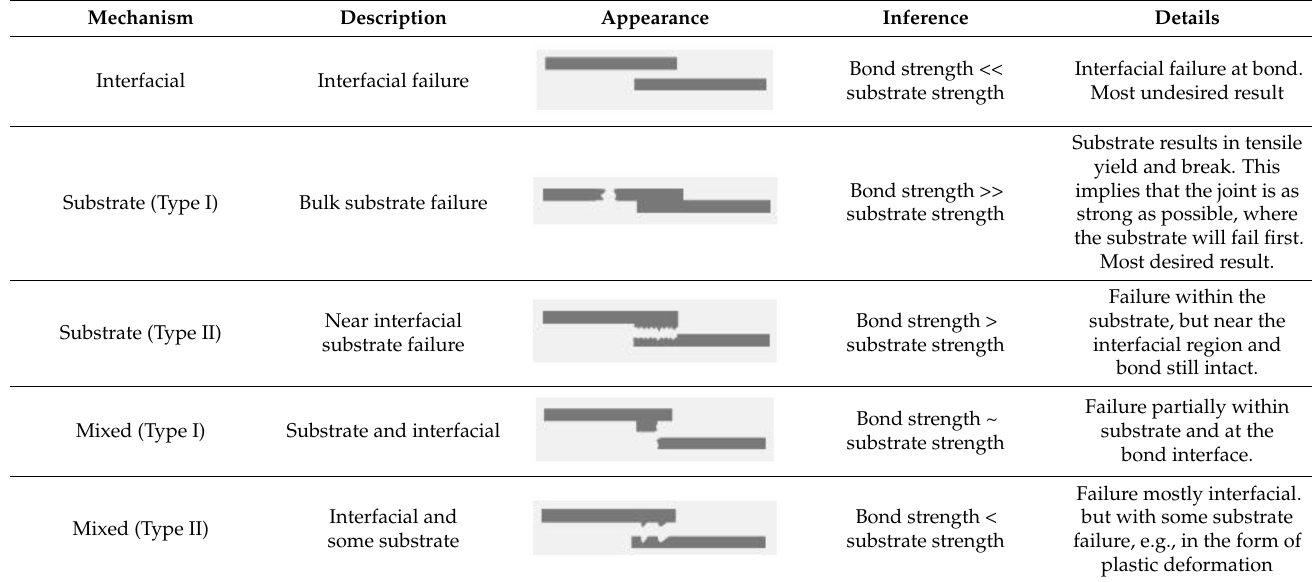
Figure 22. Post-failure SEM images of the weld interface. ( A ) Interfacial failure of the joint in the amorphous sample ( B ) Mixed failure mode in SC sample. ( C ) View of inset shown in (B). ( D ) View of inset shown in (C). Reproduced with permission from Ref. [10]. Copyright (2010), Materials and Design. Table 5. Various modes of failure in the case of lap joint geometry [10]. Reproduced with permission from Ref. [10]. Copyright (2010), Materials and